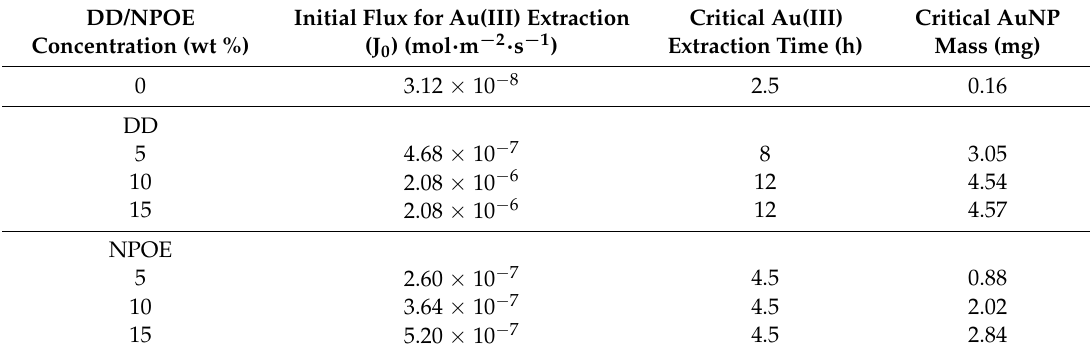
Table 2. “Critical AuNP mass”, initial Au(III) flux, and “critical” Au(III) extraction (loading) time for PIMs containing 20 wt % Aliquat 336 and different concentrations of DD or